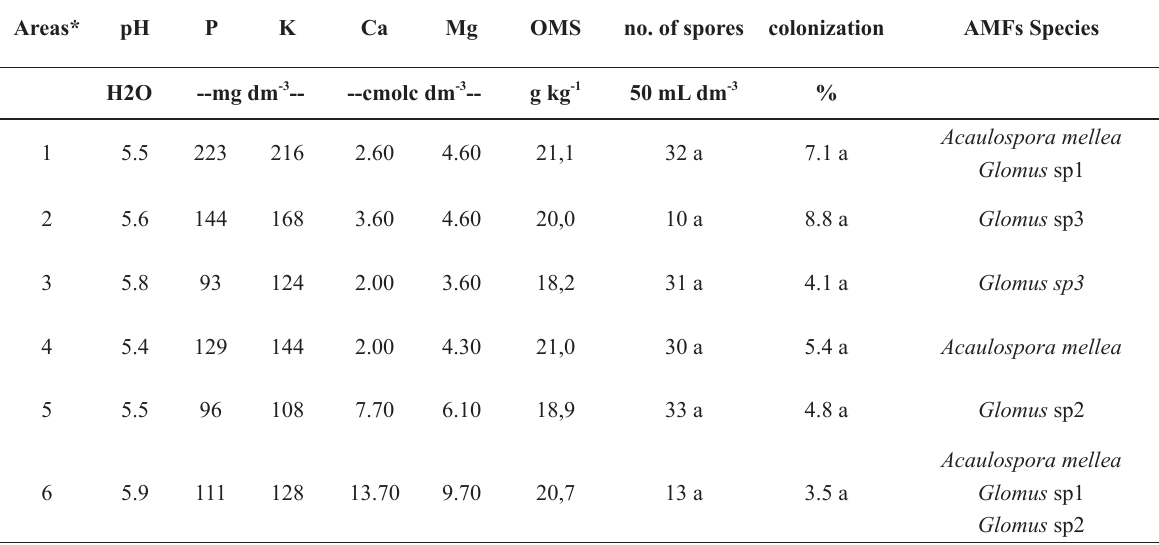
Evaluation of the study areas, determining the number of spores, mycorrhizal colonization, AMFs species diversity, and chemical characterization of the studied